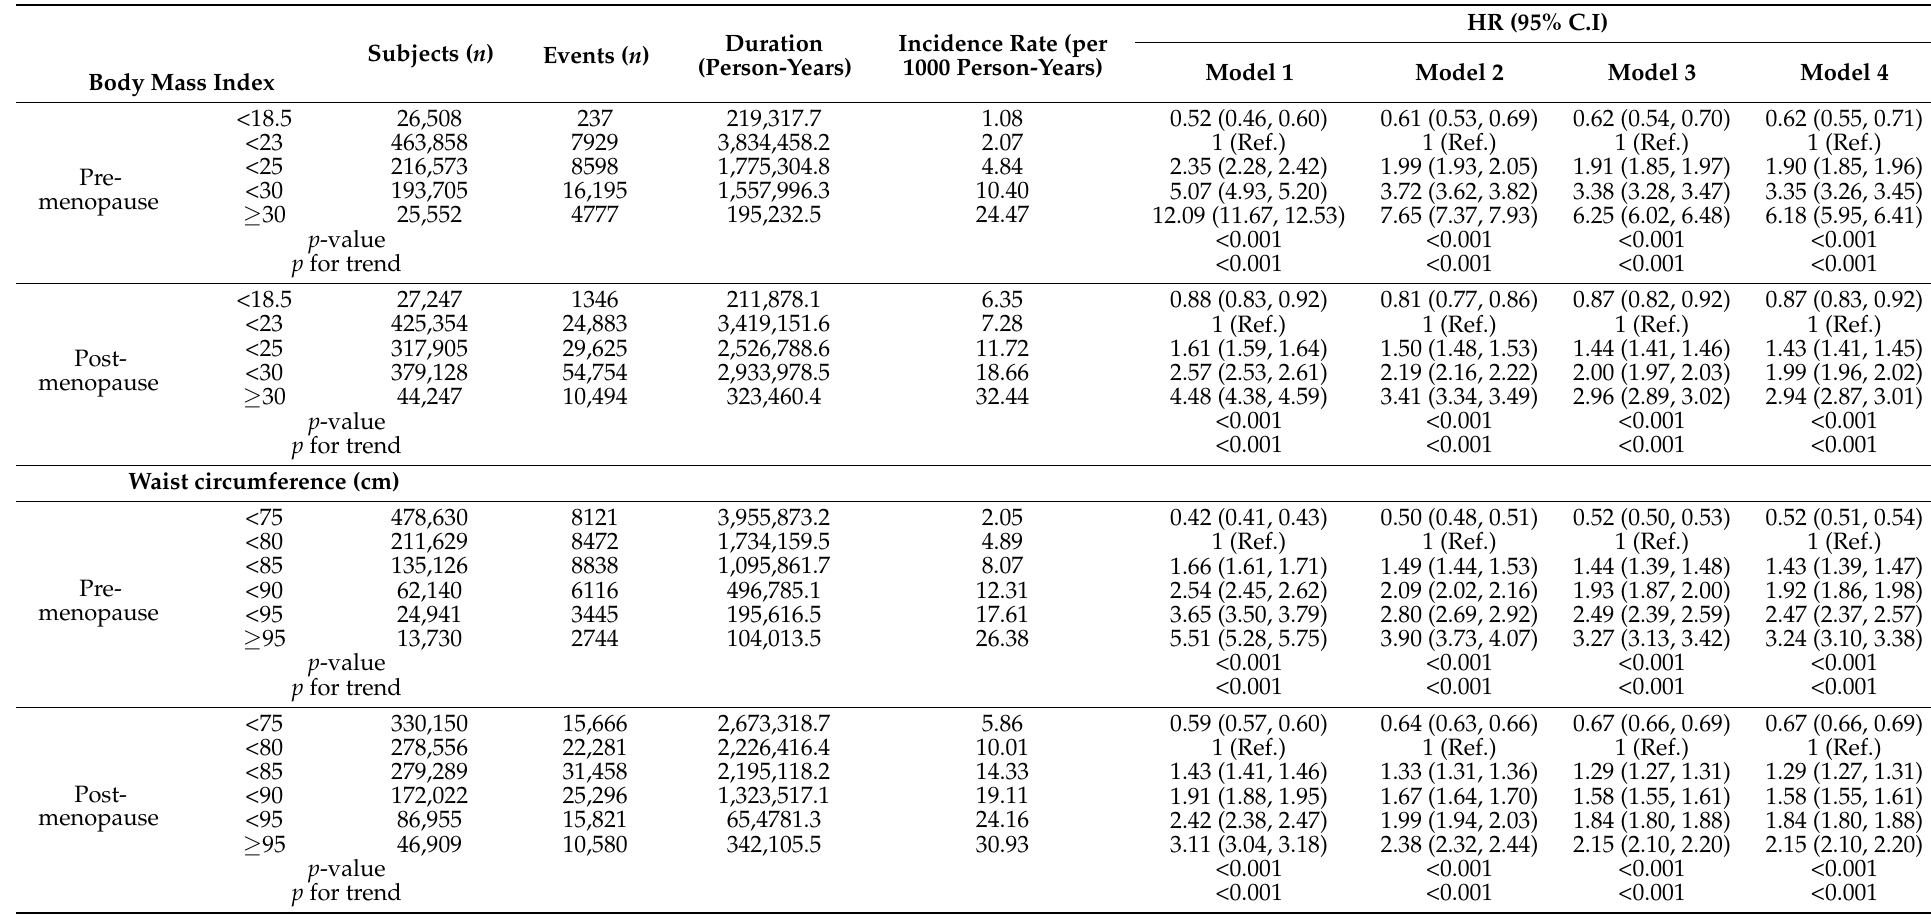
Table 2. Associations between body mass index, waist circumference, and type 2 diabetes risk by menopausal status.